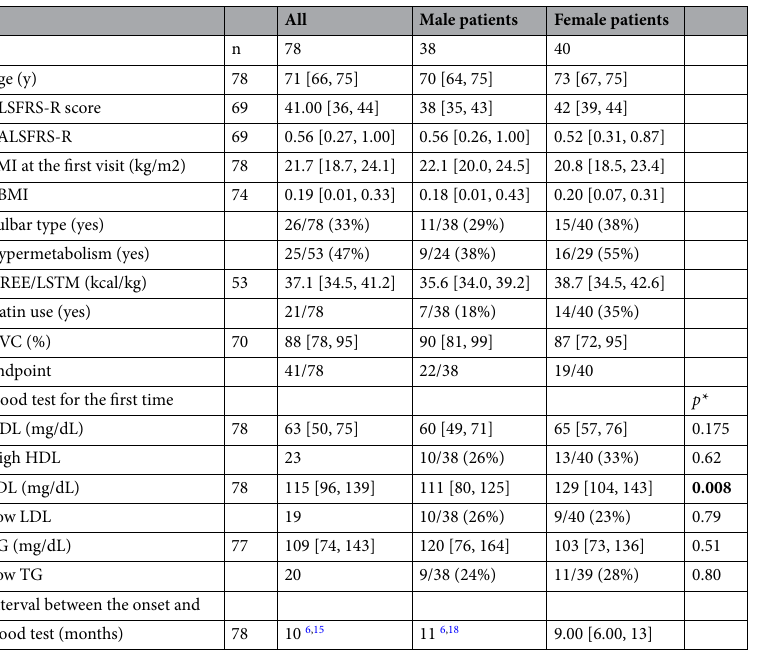
Table 1. Demographic and clinical data. Data are presented as median [interquartile range]. Due to missing values, the number corresponding to each factor does not necessarily add up to the total number of 78. *P-value is based on Fisher’s exact test or the Mann–Whitney U test. ALSFRS-R, Revised Amyotrophic Lateral Functional Rating Scale; BMI, body mass index; BMM index, BMI muscle metabolism index; mREE, measured resting energy expenditure; LSTM, lean soft tissue mass; VC, vital capacity; HDL, high-density lipoprotein; LDL, low-density lipoprotein; TG, triglycerides. Significant values are in